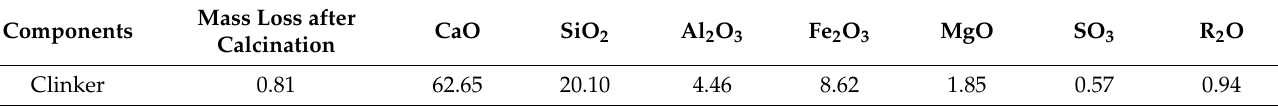
Table 1. Clinker chemical composition.